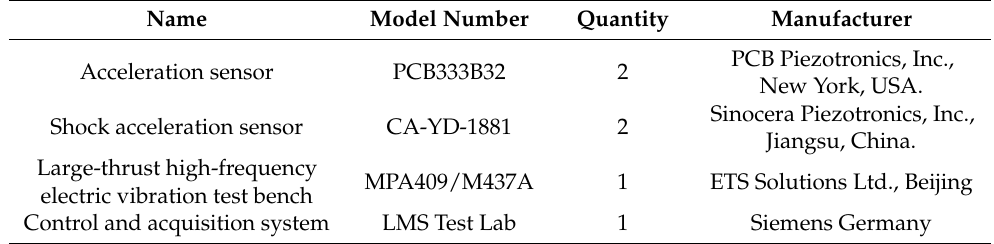
Table 4. Experimental equipment.